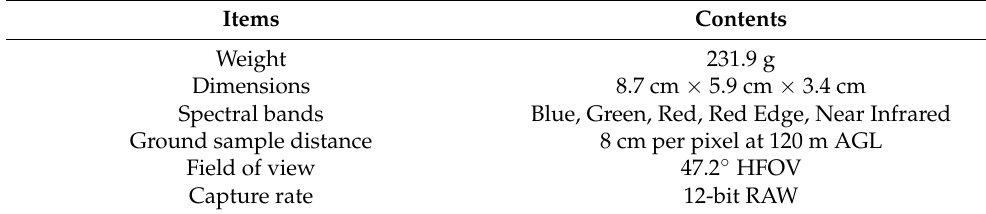
Table 1. Specifications of the Micasense RedEdge MX.